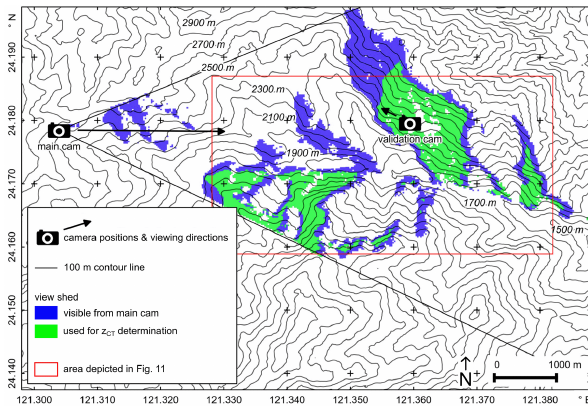
Figure 3. Camera positions and the view shed of the main